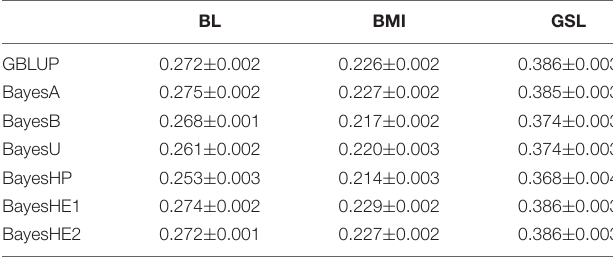
TABLE 4 | Prediction accuracies of mice data using six-fold cross-validation with five replications. BL